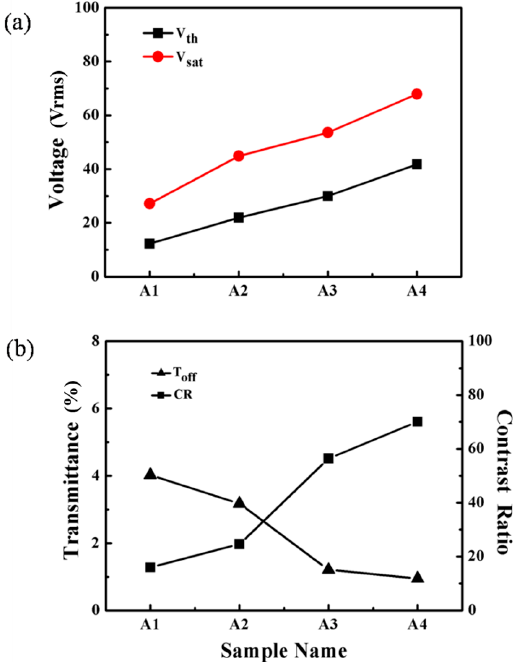
Figure 3. ( a ) Threshold voltage ( Vth ) and saturation voltage ( Vsat ) of samples A1–A4; ( b ) Off-state light transmittance (Toff) and contrast ratio (CR) of samples A1–A4.